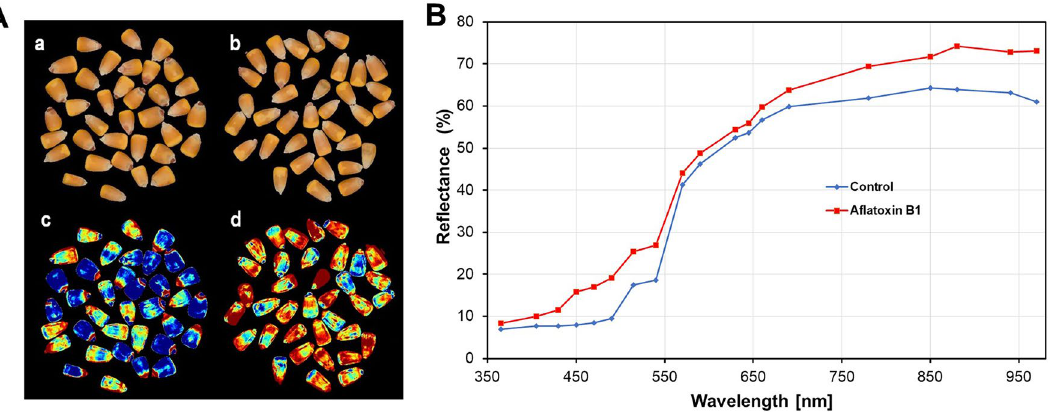
Figure 3. ( A ) sRGB images (a, b) and corresponding nCDA images (c, d) of Zea mays L. seedslot for control (uncontaminated) and AFB